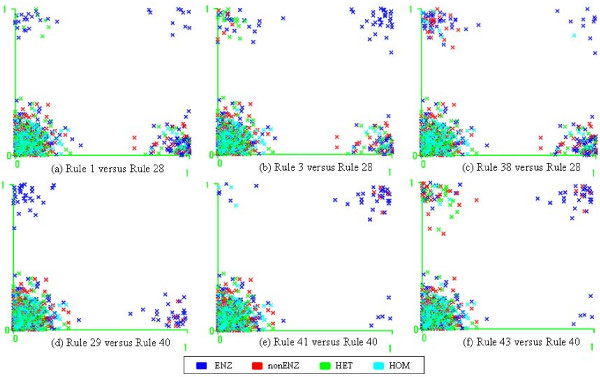
2D plots for pairs of association rules. These plot data points by pairs of association rules. X and Y axes are a pair of rules and each of them have two boolean values. 0 represents negative data points not meeting with a rule of each axis and 1 represents for positive data points meeting with the rule. The data points on the upper left corner meet a rule used for Y axis and the data points on the down right corner meet a rule used for X axis. The points on the upper right corner meet with both rules used for X and Y axes. Plots in Figure 3(a), (b), and (c) characterize distribution of inhibitors in enzyme-inhibitors interactions. Rule 28 is used for X axis in plots (a), (b) and (c). Rules 1, 3 and 38 are used for the Y axis in those plots. (a) represents an example for a pair of rules both including SSE information (e.g. helix and loop content). (b) and (c) show examples for combination of SSE content information (Rule 28: "Nohelix ") with other properties (e.g. SCOPClass, number of atoms and etc.). Plot (b) (Rule 3 versus Rule 28) is identical to the plot generated by Rule 29. Enzymes interacting with a group of inhibitors characterized by (a), (b), and (c) are featured by in Figure 3(e), and (f). Enzymes and inhibitors described by Rules 40 and 29 respectively are plotted in (d) where there is no point matching with both rules. Plot (d) reflects proper interpretation of association rules regarding interactions between enzymes and inhibitors.